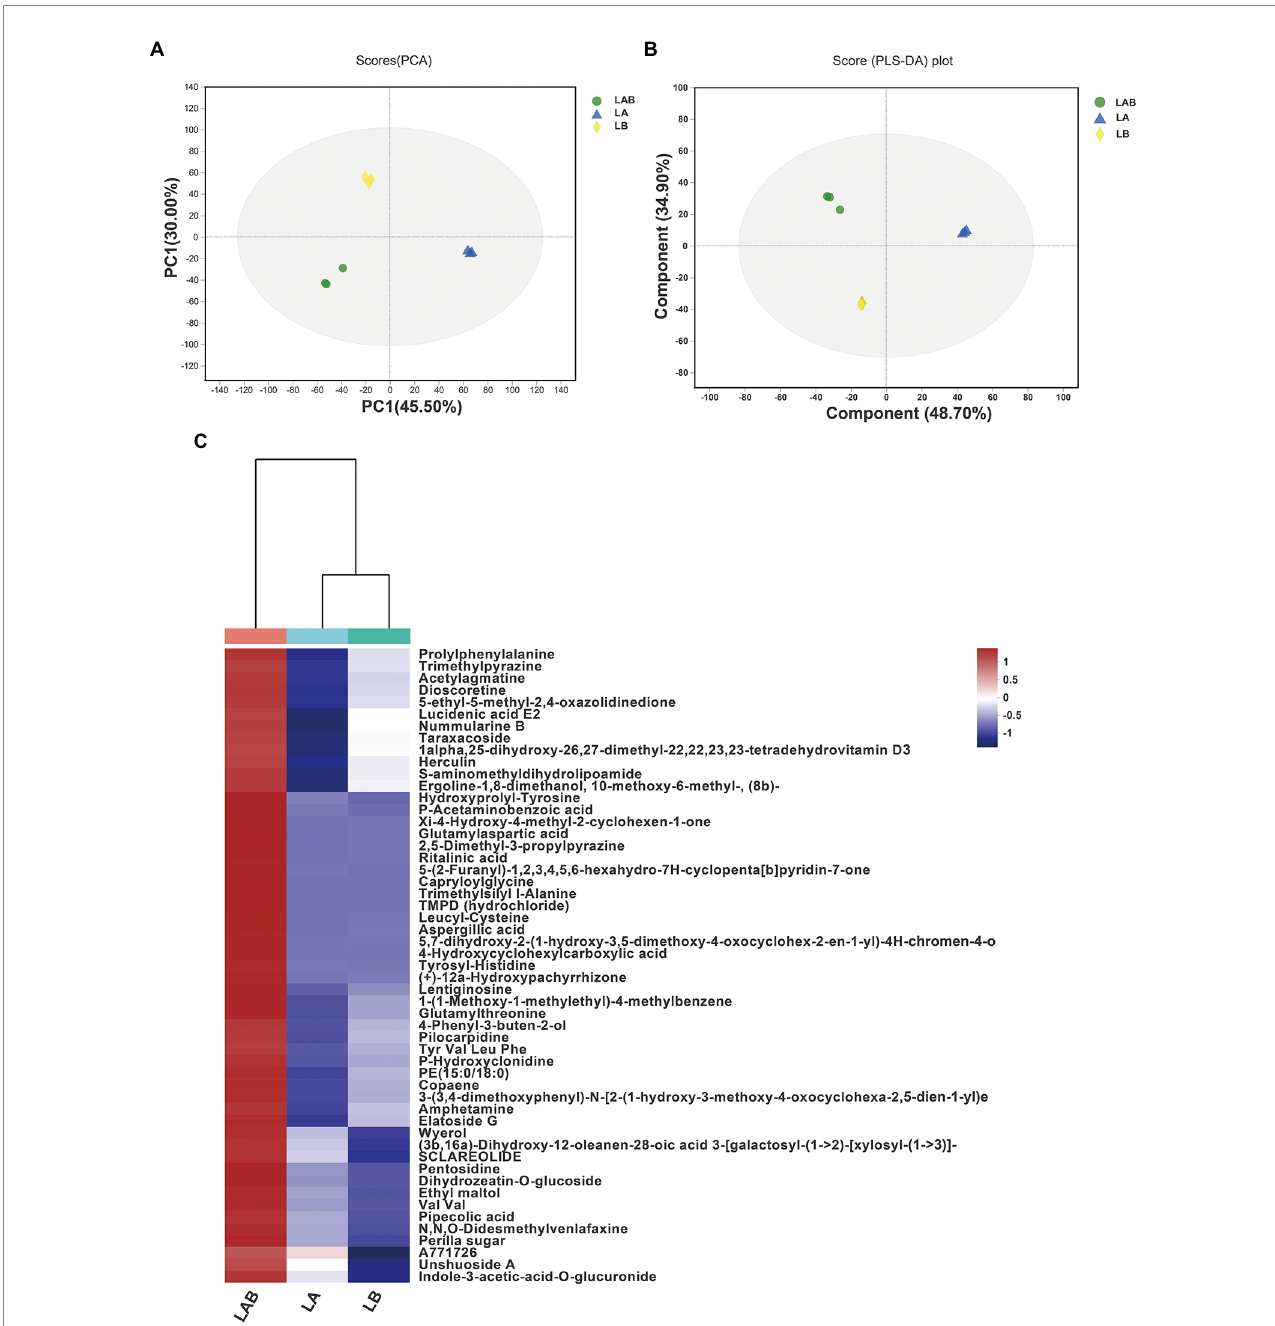
FIGURE 2 Principal components analysis (PCA) score plots of extracellular metabolites (A) . Partial least squares discriminant analysis (PLS-DA) score plots of extracellular metabolites (B) . Hierarchical clustering analysis (HCA) of the 59 extracellular metabolites only overexpressed in co-culture group and represented on a heatmap (C) . (LA, extracellular metabolites of E. amstelodami pure culture; LB, extracellular metabolites of B. licheniformis pure culture; LAB, extracellular metabolites of